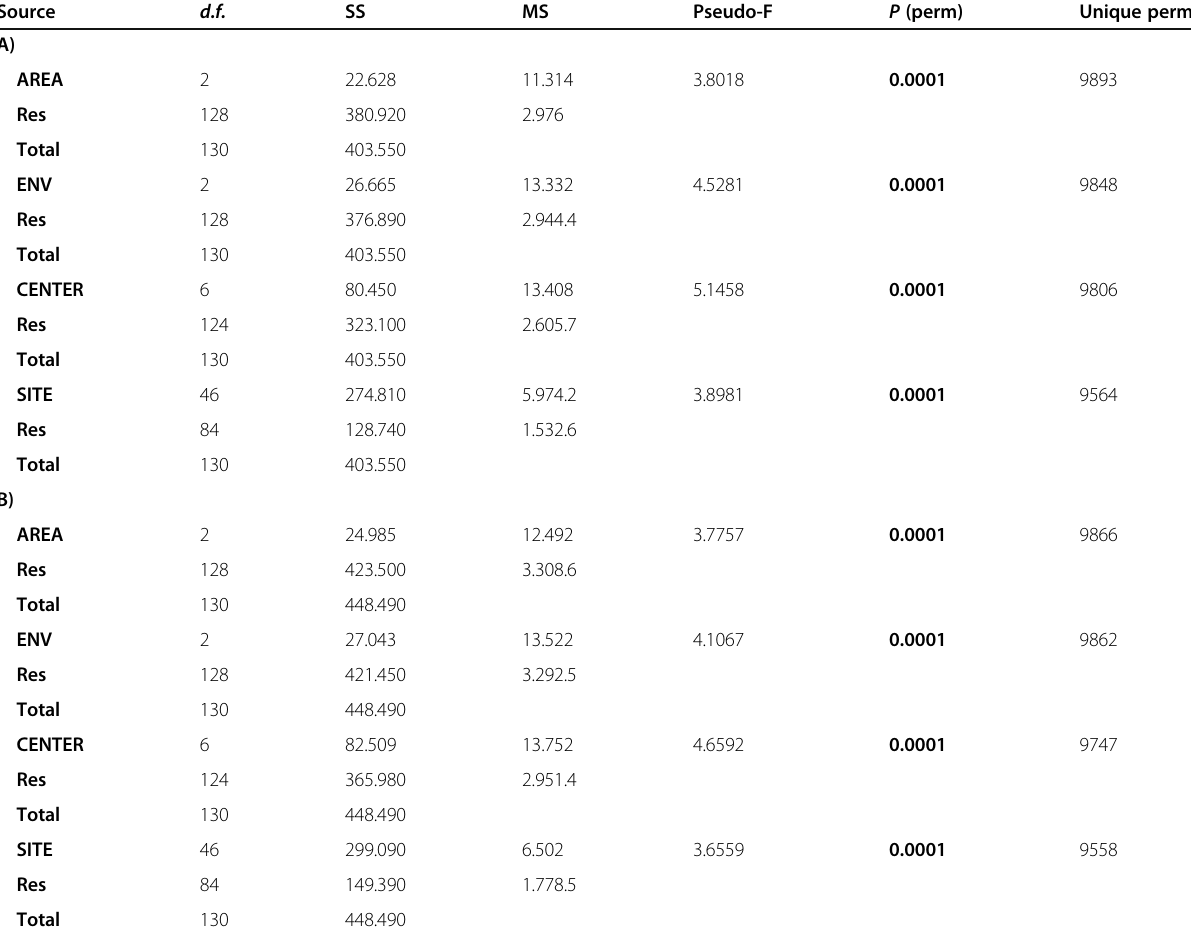
Table 2 Output of PERMANOVA main tests for (A) abundance fourth-root transformed with the Bray-Curtis index, (B) biomass fourth-root transformed with the Bray-Curtis index. Factors of analysis were channel area (AREA), environment (ENV), farming center (CENTER) and sampling site (SITE). P(perm) < 0.05 values are in bold